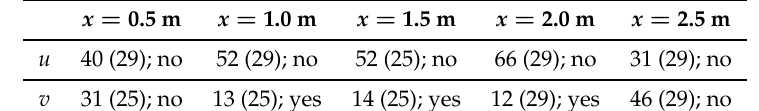
Table 2. Two-tailed Wilcoxon signed-ranks test for paired samples with φ = 0.05. Values in cells represent the test statistic, critical statistic (in brackets), and whether there is a significant difference, i.e., yes/no.